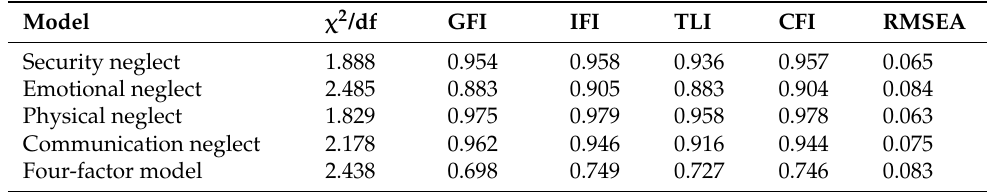
Table 5. Confirmatory factor analyses ( n =